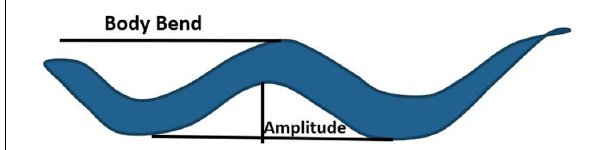
FIGURE 2 | Body bend and amplitude of a sinusoidal wave during locomotion in C. elegans. The image has been adapted fromPandey et al.